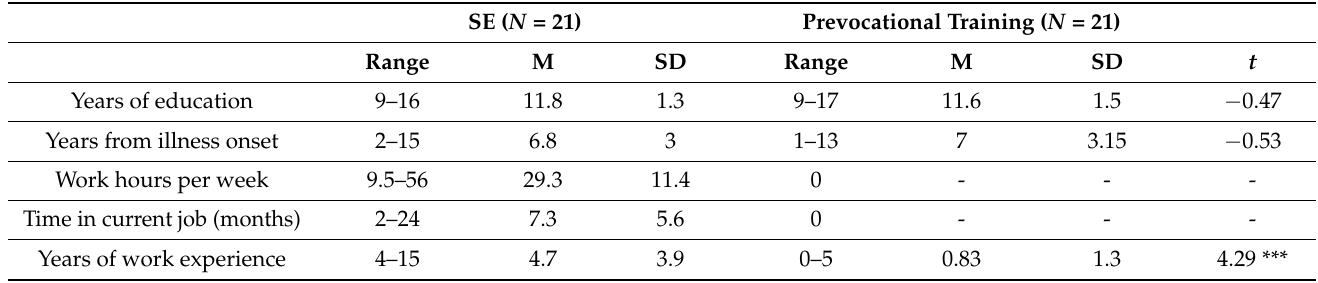
Table 1. Comparing sample characteristics of both groups (continuous variables).